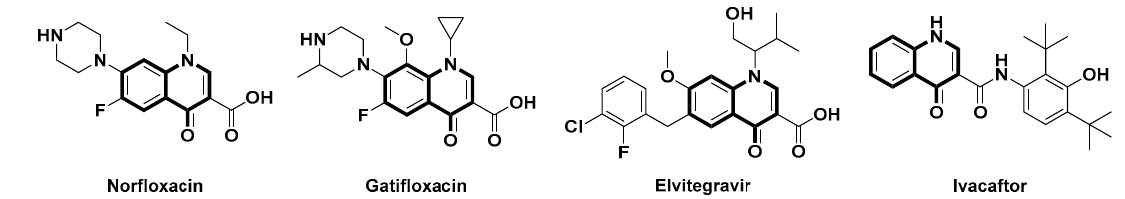
Figure 1. Representative drugs containing quinolin-4(1 H )-ones.